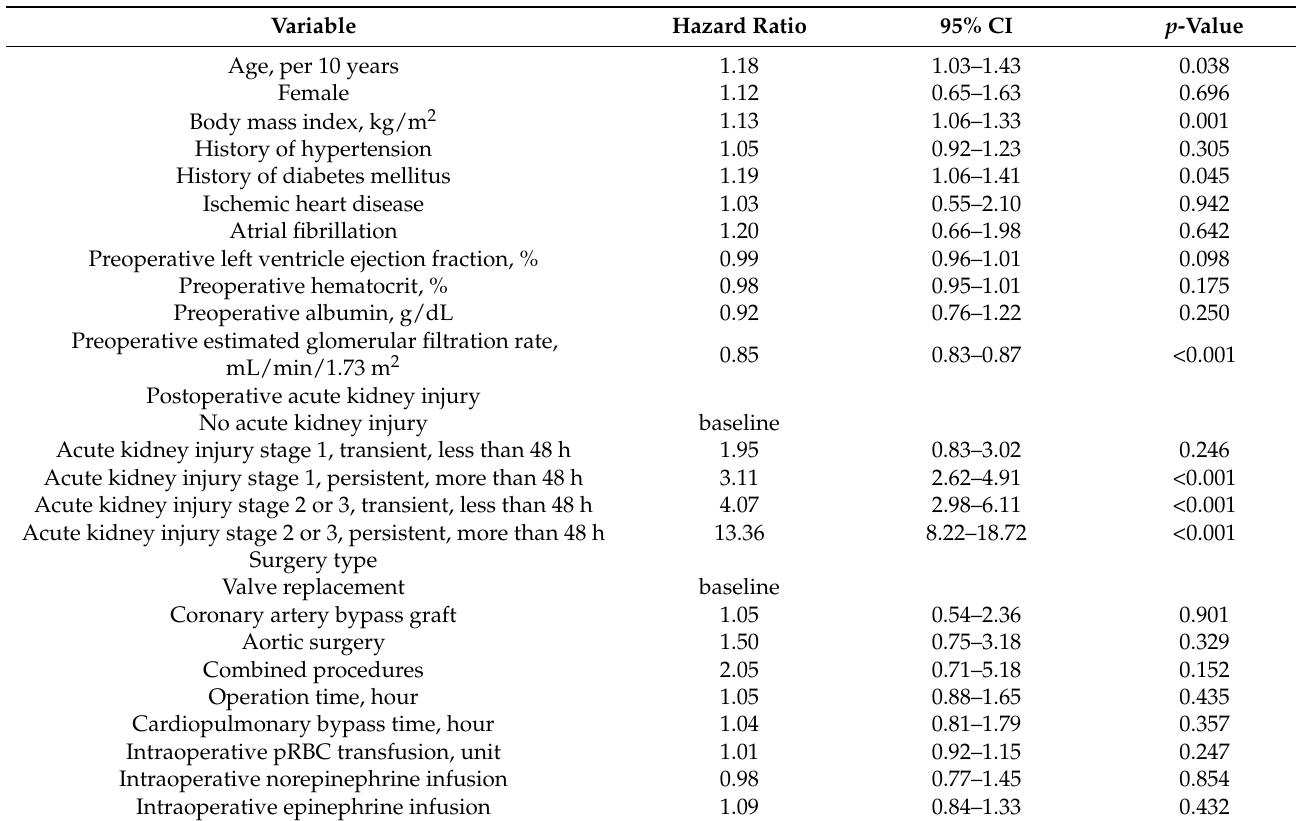
Table 2. Multivariable Cox regression analysis for new-onset chronic kidney disease or all-cause mortality during three years after cardiac surgery ( n =